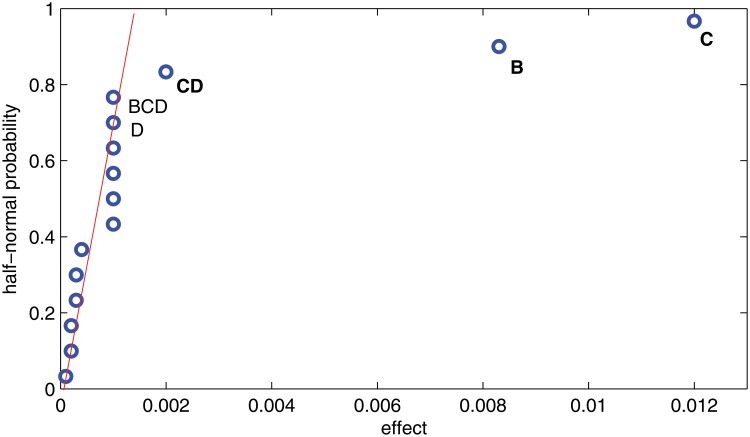
Half-normal plot of effects for Y
t.